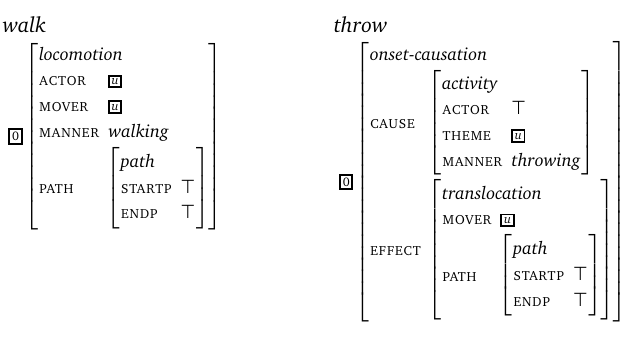
Figure 14: Possible frame-semantic representations of some verbs of (caused)